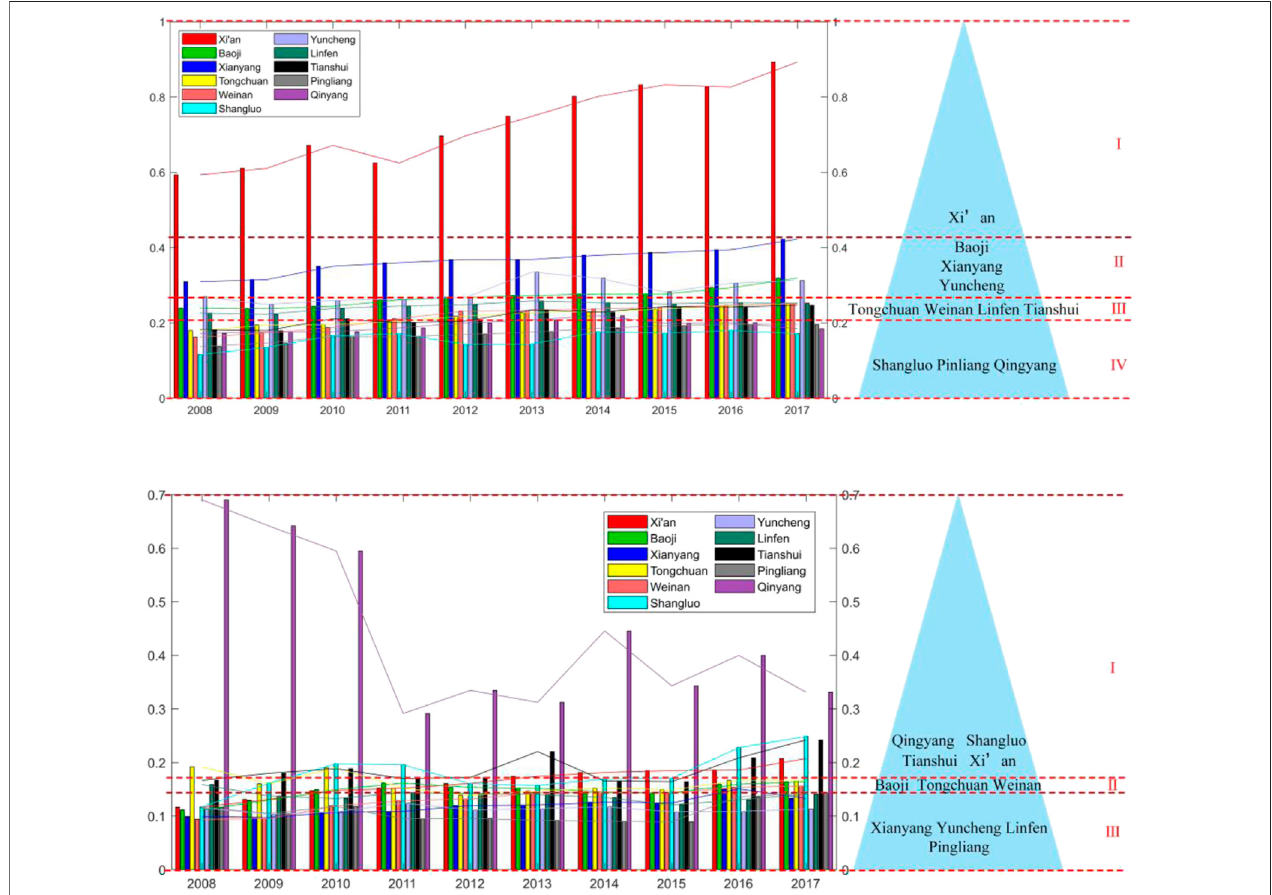
FIGURE 5 | The development trend of new-type urbanization and ecological environment quality in GZPUA.